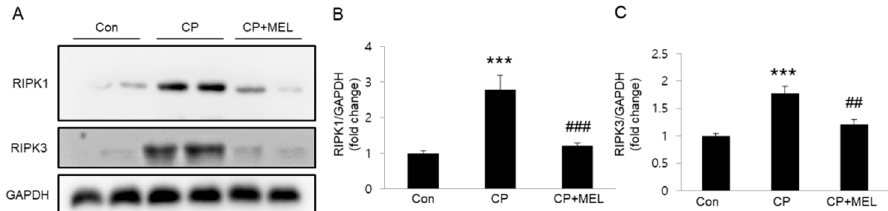
Figure 5. Effects of melatonin (MEL) on necroptosis in kidneys of mice treated with cisplatin (CP). ( A ) Western blots of receptor-interacting serine/threonine protein kinase 1 (RIPK1) and RIPK3 levels in kidneys. ( B ) Quantification of RIPK1 level. ( C ) Quantification of RIPK3 level. *** P < 0.001 vs. Con. ## P < 0.01 and ### P < 0.001 vs. CP.